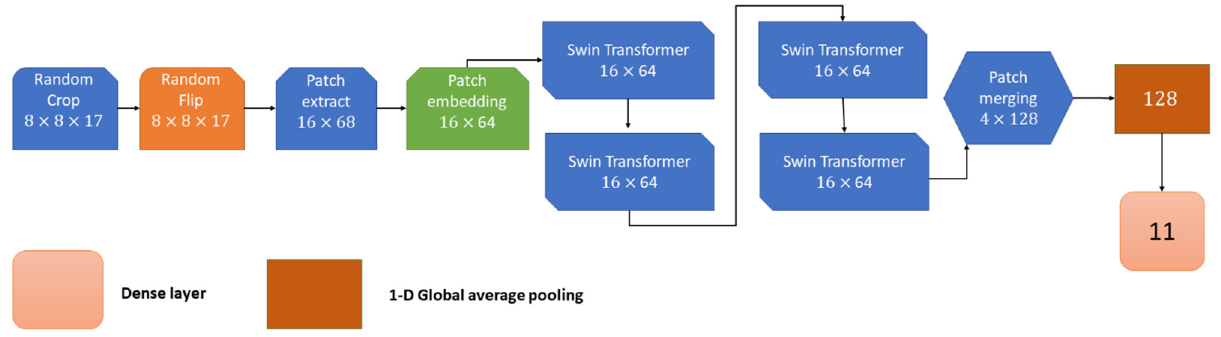
Figure 7. The architecture of the proposed Swin Transformer with four multi-head self-attention